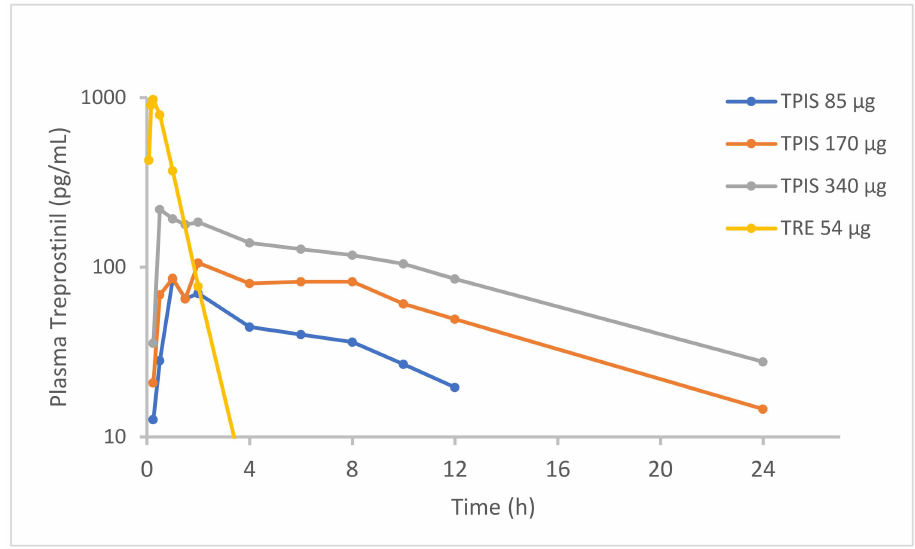
Figure 2. Pharmacokinetics (PK) of Treprostinil (TRE) in healthy volunteers after administration of Treprostinil Palmitil Inhalation Solution (TPIS) or nebulized TRE. Adapted from [104]. European Respiratory Society,